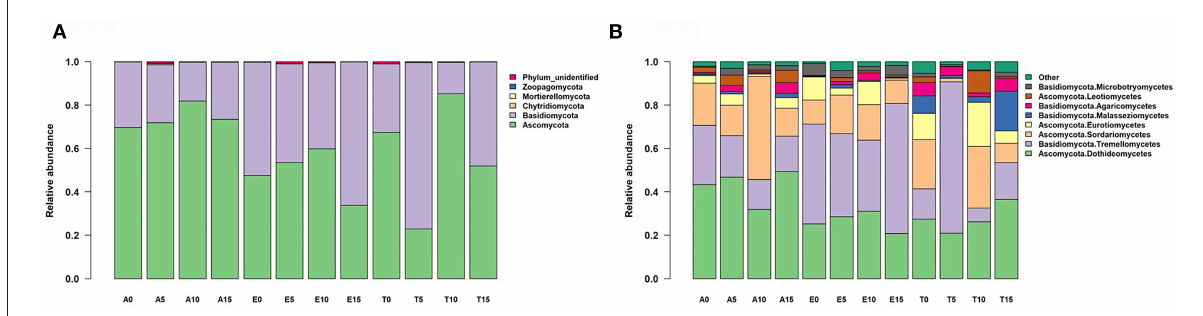
FIGURE1 Taxonomic composition, (A) phylum level, and (B) class level of the fungal communities recovered from leaf interiors of three species along the nitrogen enrichment gradients in the study site. Bars show relative abundance of different taxonomic groups. The fungal endophyte classes with relative abundances of < 0.1% were assigned to “Other”. A, Anemone rivularis ; E, Elymus nutans ; T, Thermopsis lanceolata . 0 (control), 5, 10, and 15 referring to 0, 5, 10, and 15g N (NH 4 NO 3 ) m − 2 yr − 1 treatments, respectively.